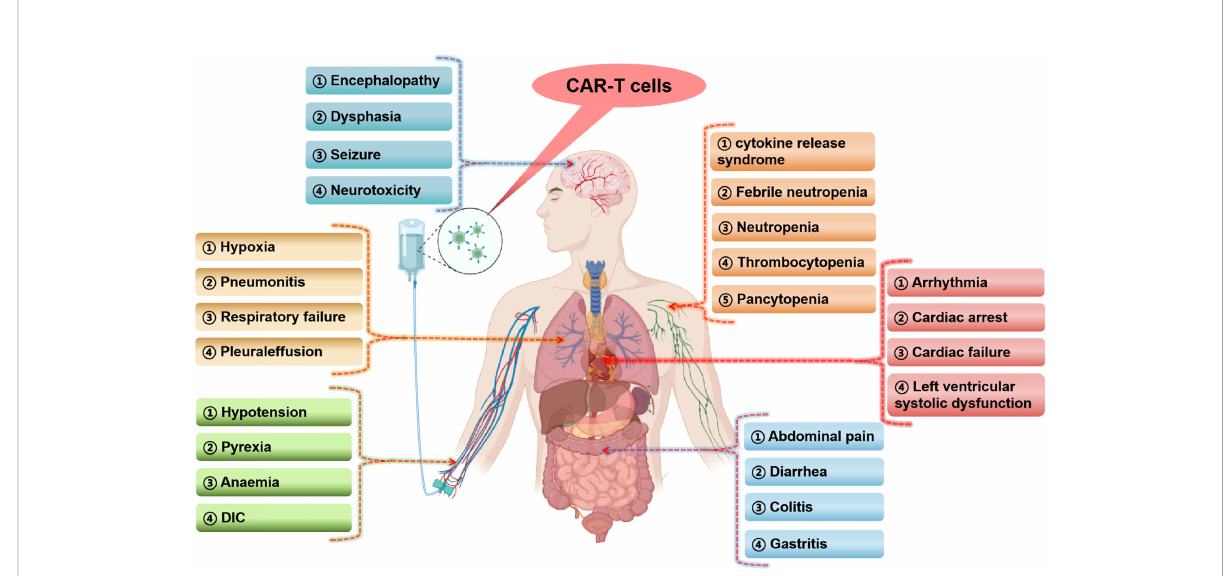
FIGURE 1 Occurrence of serious adverse events in various human systems in CAR-T cells clinical studies (The fi gure is produced using the BioRender online graphics website). DIC, disseminated intravascular